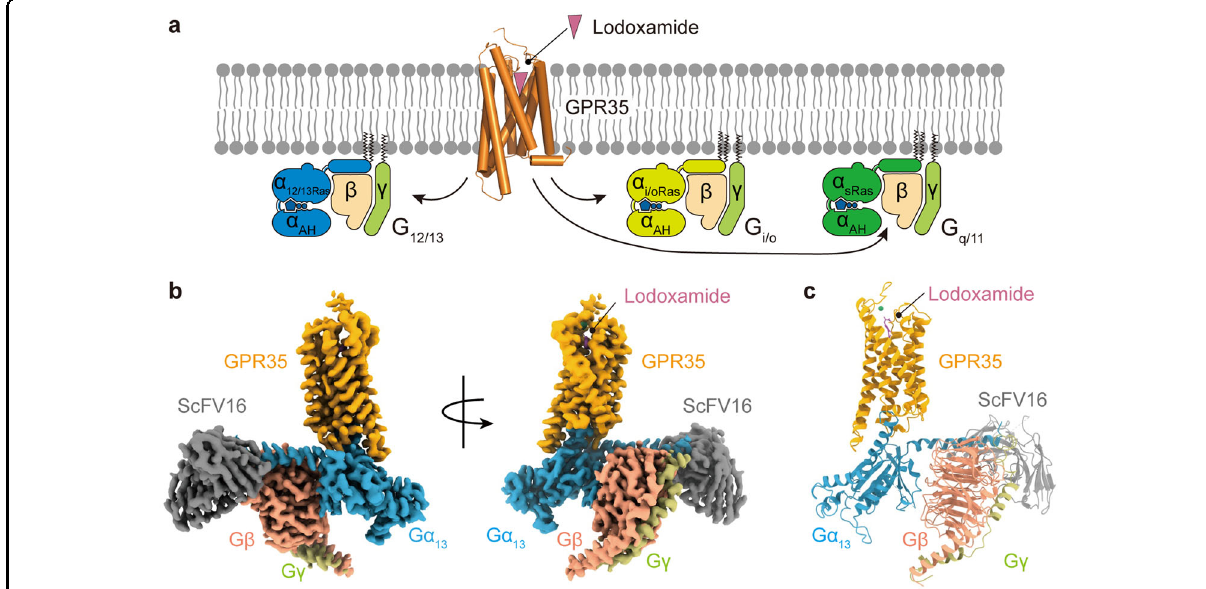
Fig. 1 Overall structure of the lodoxamide – GPR35 – G 13 – scFv16 complex. a Schematic diagram of lodoxamide-mediated activation and G protein coupling of GPR35. b Orthogonal views of the density map for the lodoxamide – GPR35 – G 13 – scFv16 complex. GPR35 is shown in orange, G α 13 in slate blue, G β in salmon, G γ in lime, scFv16 in grey, and lodoxamide in magenta. c Orthogonal views of the model of the lodoxamide – GPR35 – G 13 – scFv16